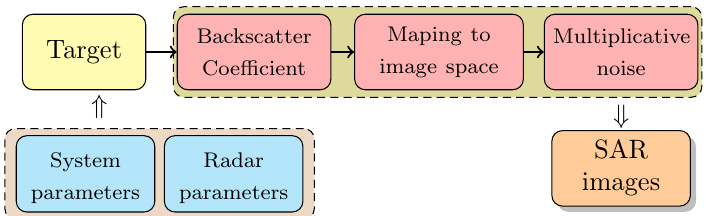
Figure 4. Process of feature-based SAR image